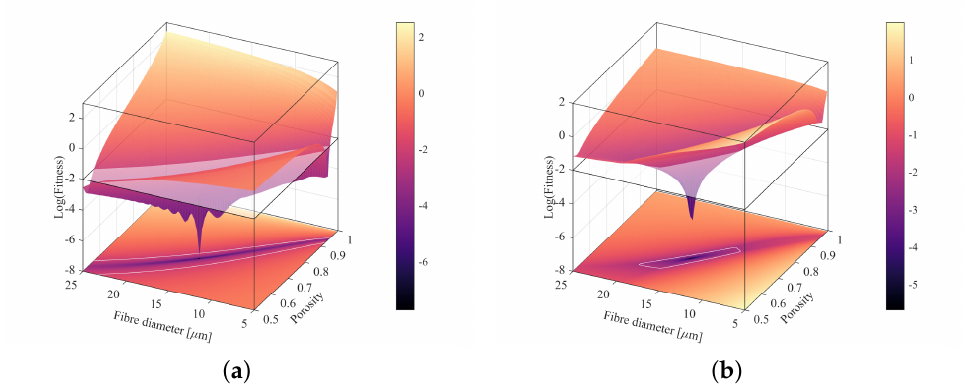
Figure 11. 3D profile of the logarithm of fitness function versus the porosity φ and fibre diameter d with the fixed standard deviation σ s , and 2D projection along φ − d plane with contour plot at Log ( Fitness ) = − 2, ( a ) σ t s = 0.21, inversion from Z s , ( b ) σ t s = 0.21, inversion from ( Z c , k c )